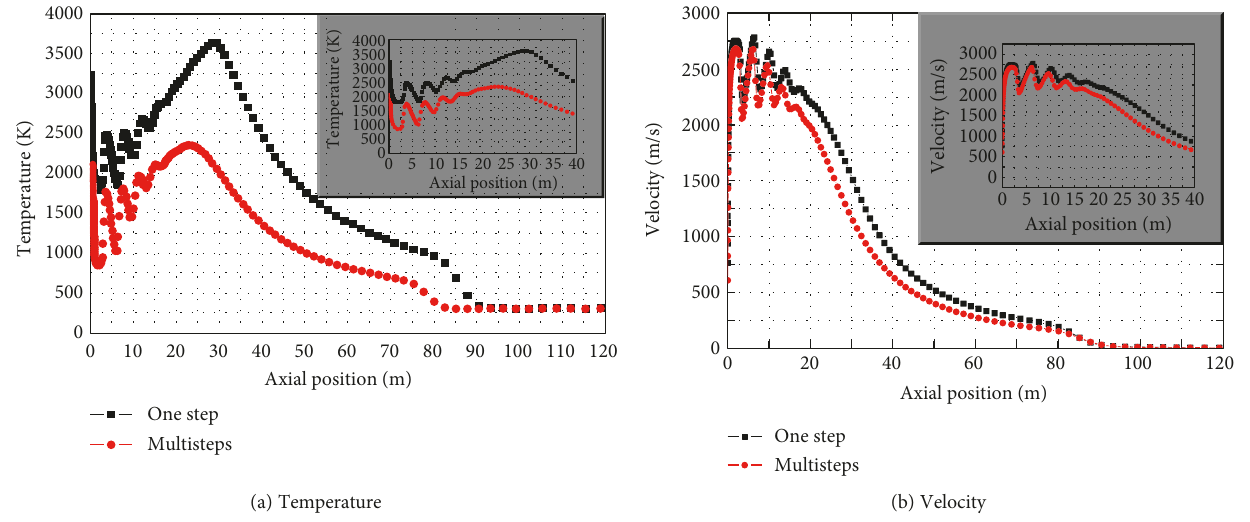
Figure 8: Parameters on the plume axis of the single-nozzle